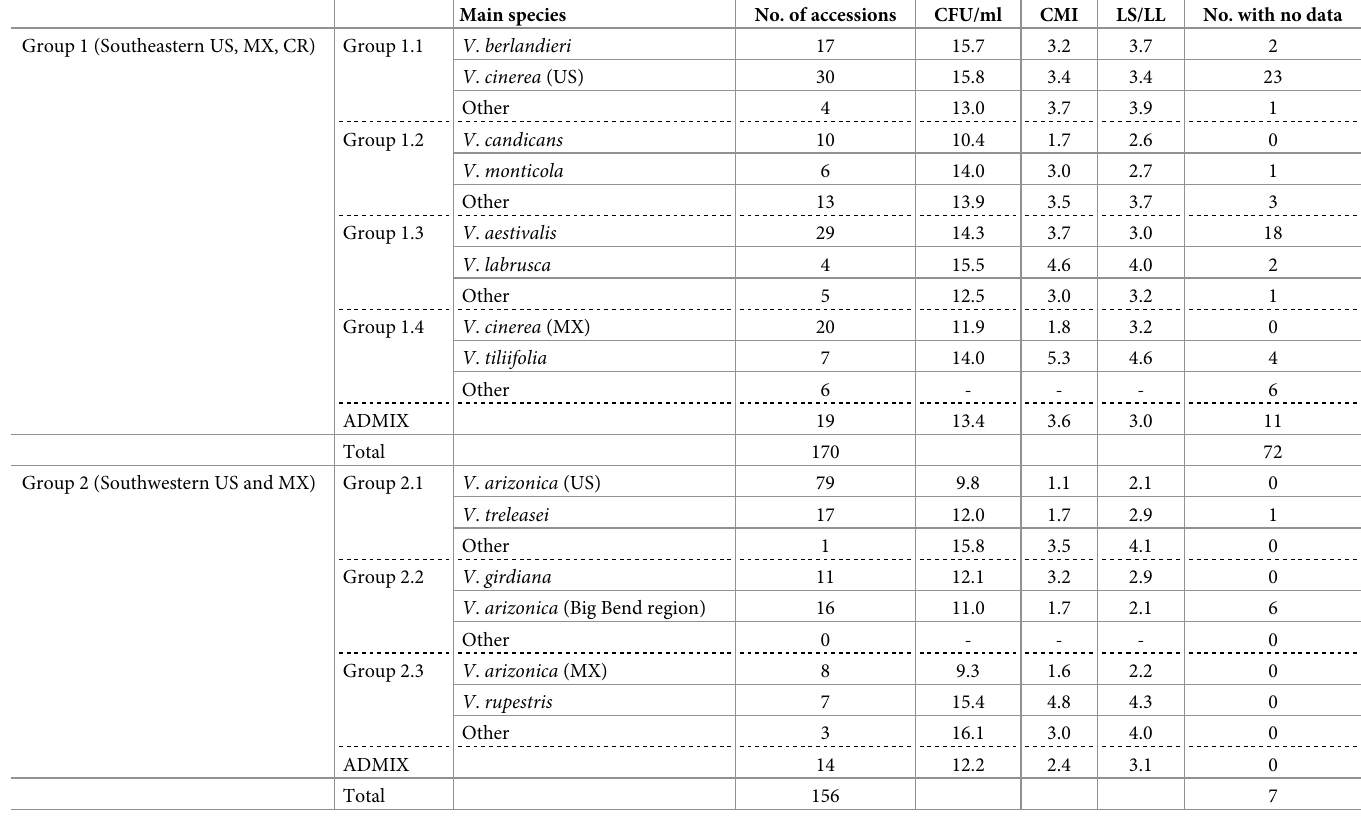
Table 5. Summary of PD resistance across different species groups as defined by the hierarchal STRUCTURE analysis. For the three parameters, lower scores exhibit higher resistance to the